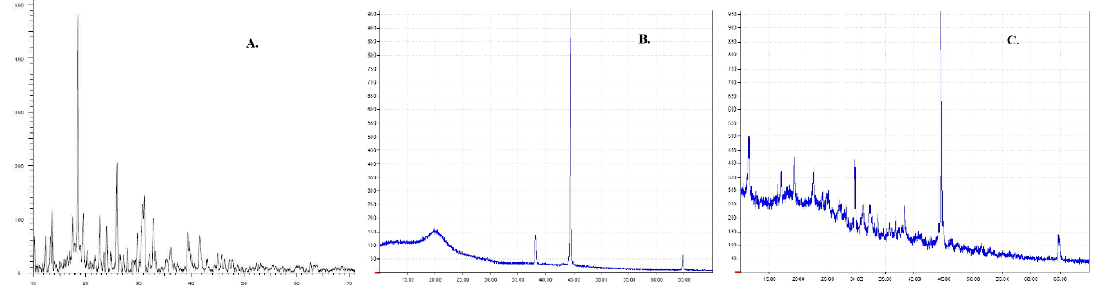
Figure 5. XRD results for ( a ) plain Ag-FSE, ( b ) plain chitosan (CS), and ( c ) Ag-FSE CSNPs.